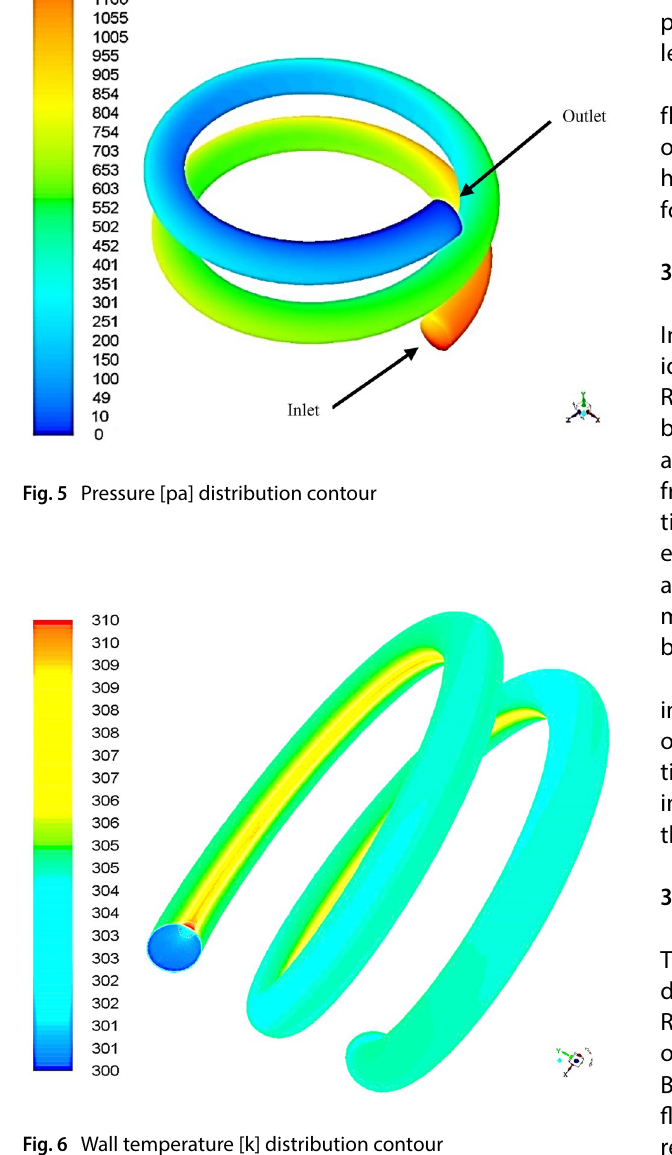
Fig. 6 Wall temperature [k] distribution